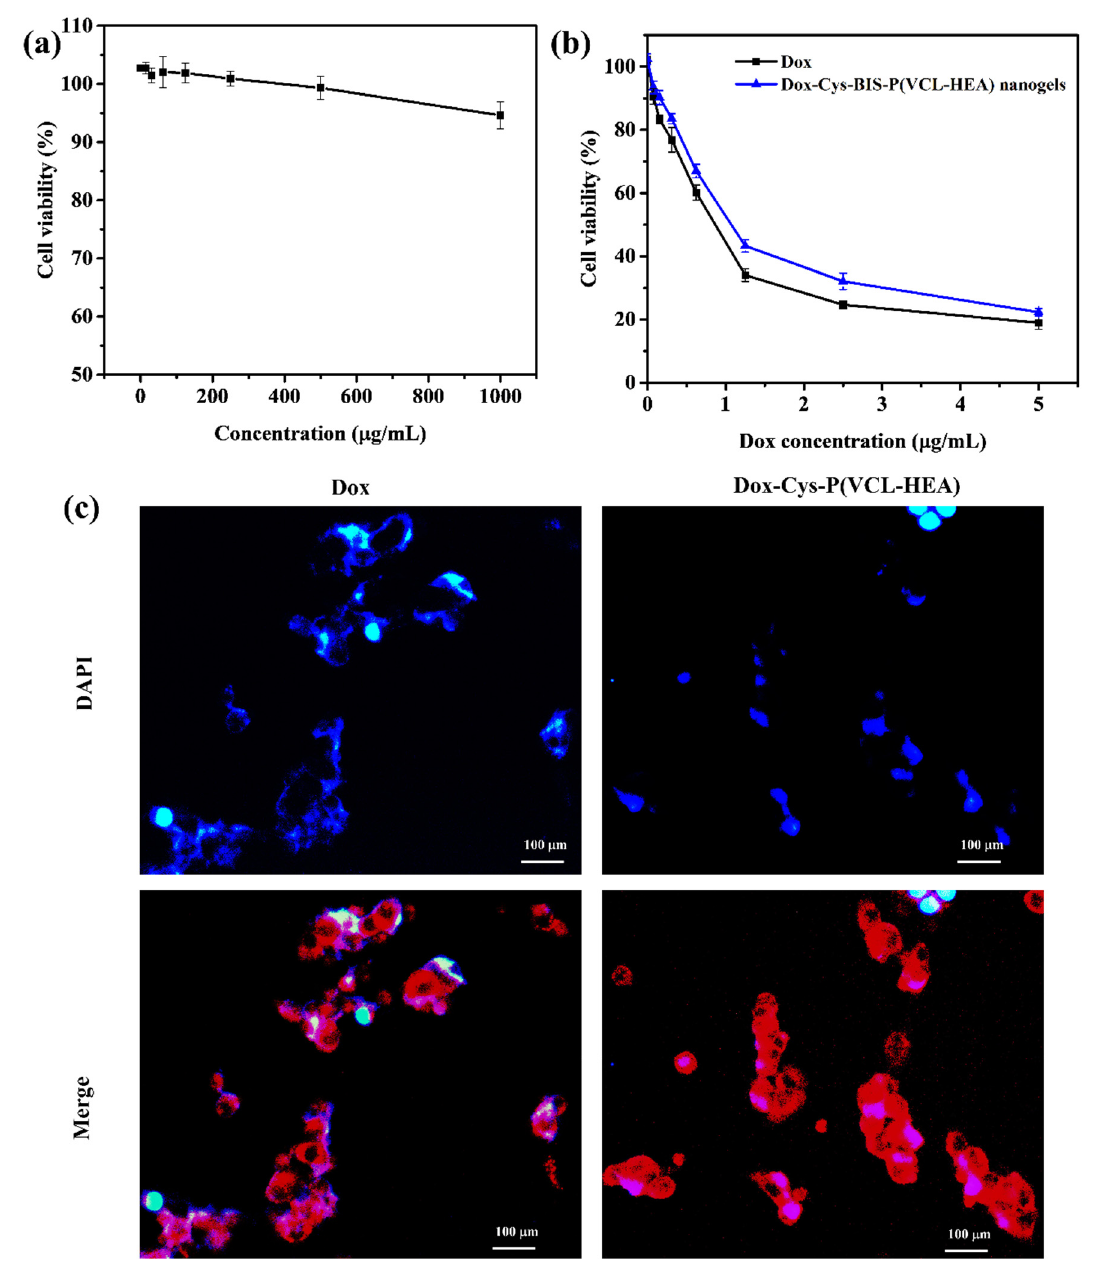
Figure 5. ( a ) In vitro cytotoxicity of pure nanogels treated with CCDK-normal skin fibroblasts cells with different concentrations (0–1000 μ g/mL) for 72 h incubation. ( b ) In vitro cytotoxicity of Dox- loaded Cys-BIS-P(VCL-HEA) nanogels treated with HepG2 cancer cells. ( c ) Fluorescence microscopy images of samples treated with HepG2 cells for 3 h incubation (DAPI (blue) staining for nucleus and red fluorescence represent the Dox or Dox-loaded nanogels).